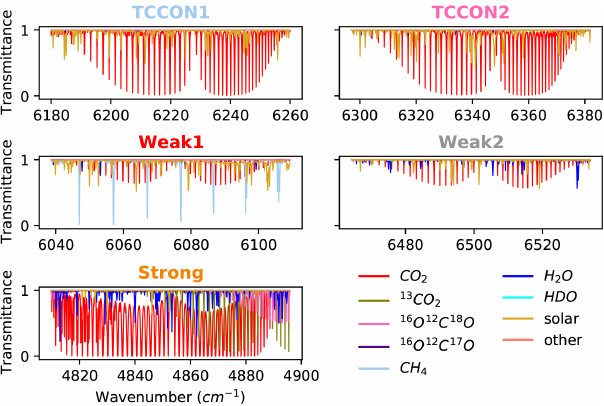
Figure 1. Contributions of different absorbing gases to the calcu- lated transmittance spectrum on a dry winter day at a solar zenith angle of 60.6 ◦ for each of the spectral windows used to retrieve CO 2